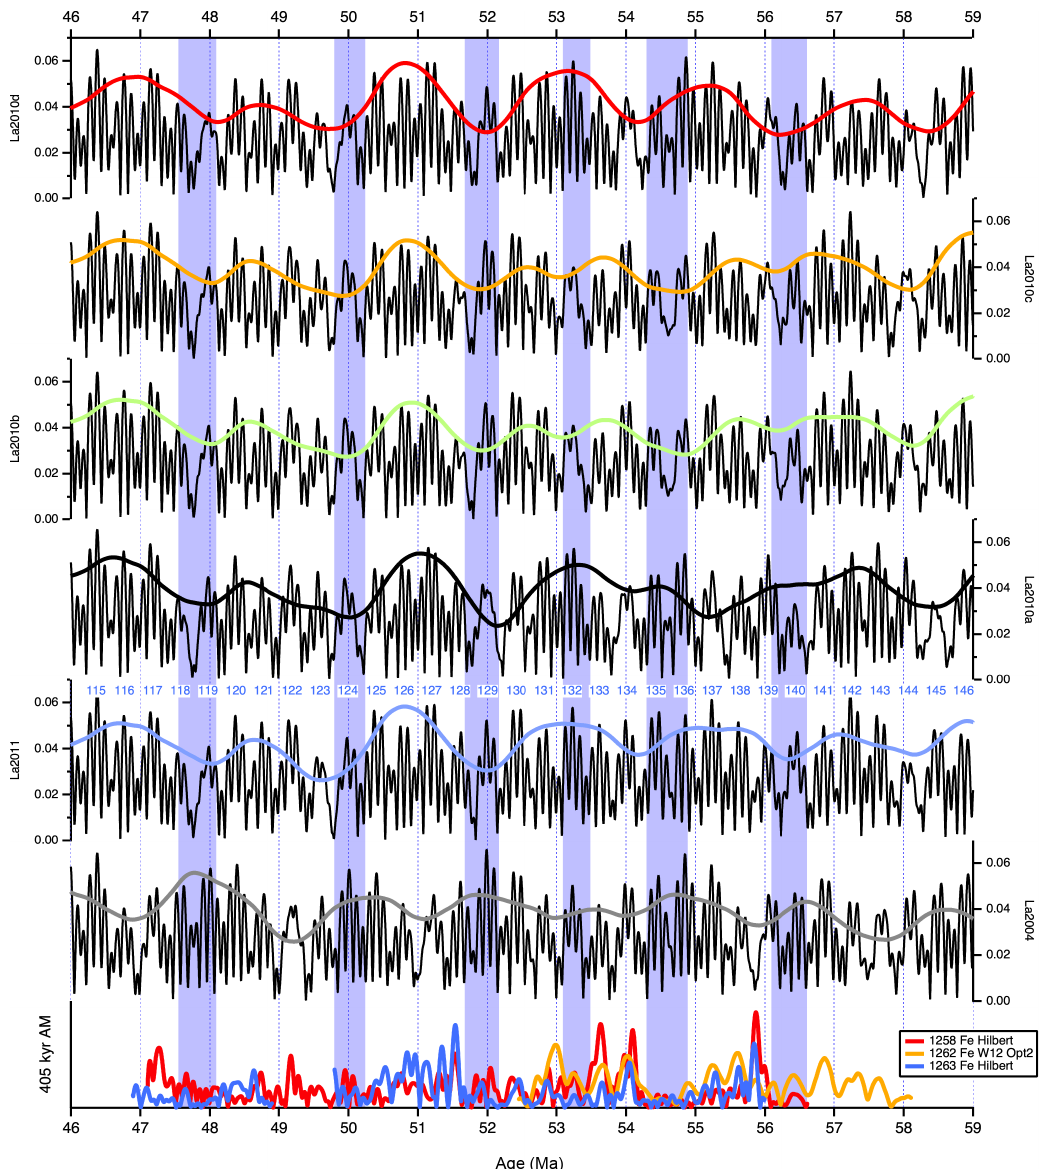
Figure 4. Comparison of the amplitude modulation (AM) of the short eccentricity cycle between the La2004, La2010, and La2011 orbital solutions and Fe intensity data from ODP Sites 1258 (red), 1262 (orange), and 1263 (blue). For the orbital solutions we also plotted the 405kyr AM. The short eccentricity AM of Sites 1258, 1262, and 1263 Fe intensity data are plotted on the 405kyr scale model. The very long eccentricity minima are highlighted by light blue bars in the orbital solutions and the Fe intensity data. Statistical and visual recognition of the cycle pattern suggests that the La2010b and La2010c solutions are most consistent with the geological